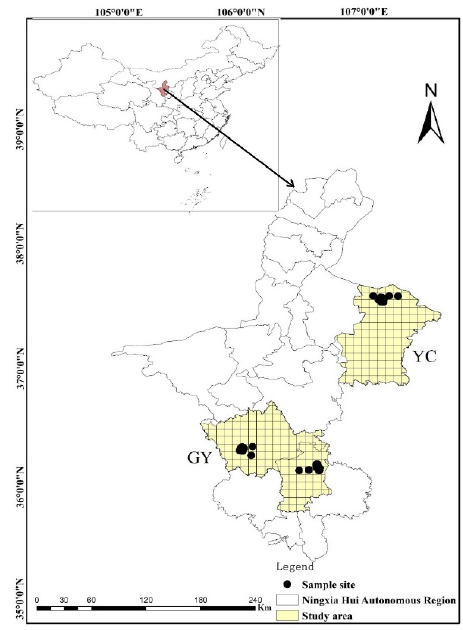
Figure 1. Study areas and sampling site (n = 124) in the Ningxia Hui Autonomous Region, north- western China (YC, Yanchi region; GY, Guyuan